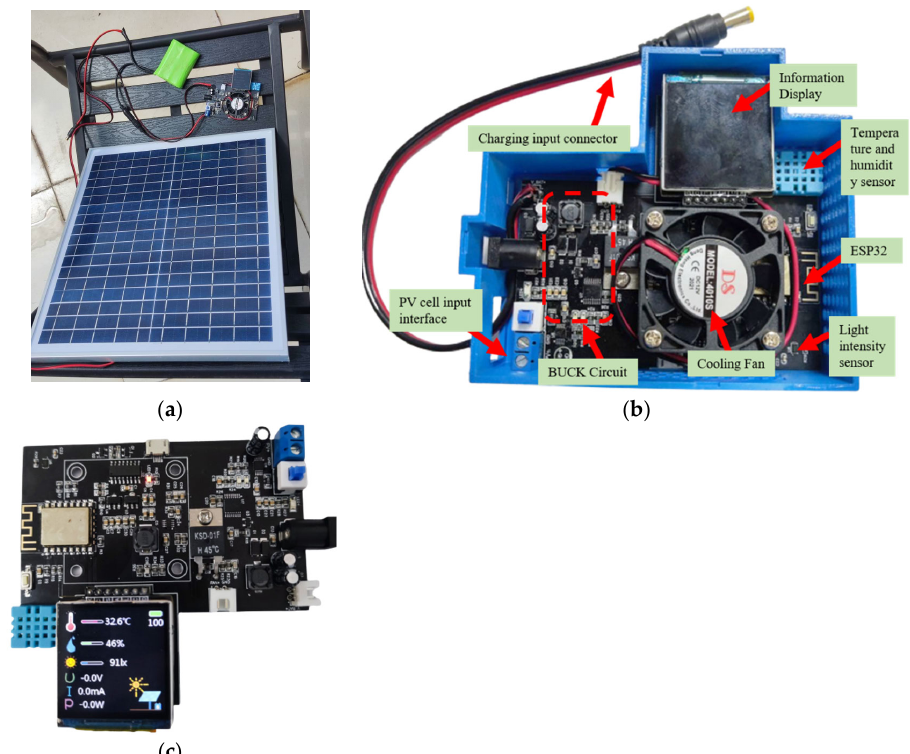
Figure 16. ( a ) Outdoor practical working test chart. ( b ) Manufactured PCB for the DC–DC converter optimally designed for the photovoltaic application. ( c ) Main control board